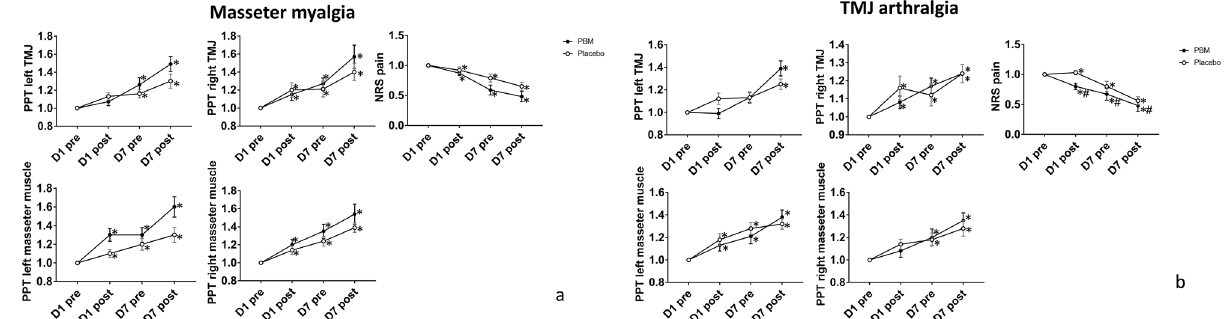
Figure 2. ( a ) The relative change of pressure pain thresholds (PPT) and NRS pain scores (mean and standard error) in masseter myalgia patients during the experiment (n = 50). Photobiomodulation (PBM) group (n = 25); Placebo group (n = 25). “*” indicates significant difference between D1-pre and other time points (P < 0.05). ( b ) The relative change of pressure pain thresholds (PPT) and NRS pain scores (mean and standard error) in TMJ arthralgia patients during the experiment (n = 50). Photobiomodulation (PBM) group (n = 25); Placebo group (n = 25). “*” indicates significant difference between D1-pre and other time points (P < 0.05); “#” indicates significant difference between PBM and placebo (P <